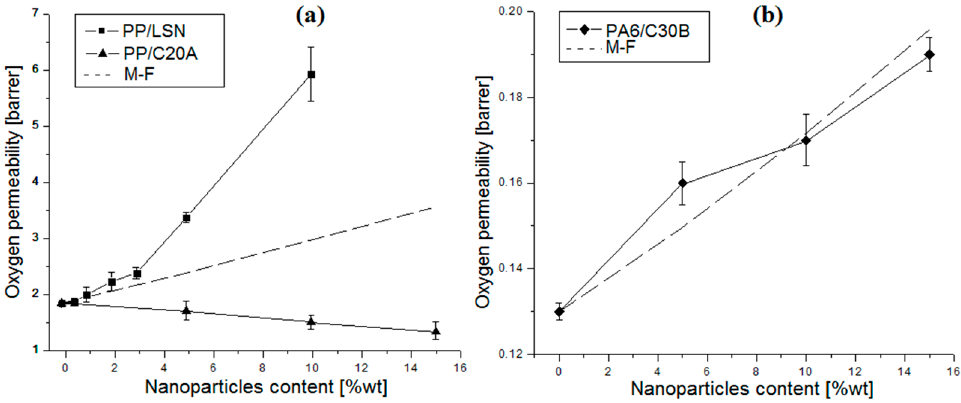
Figure 5. Oxygen permeability of nanocomposites: ( a ) PP/LSN and PP/C20A; and ( b ) PA6/C30B.